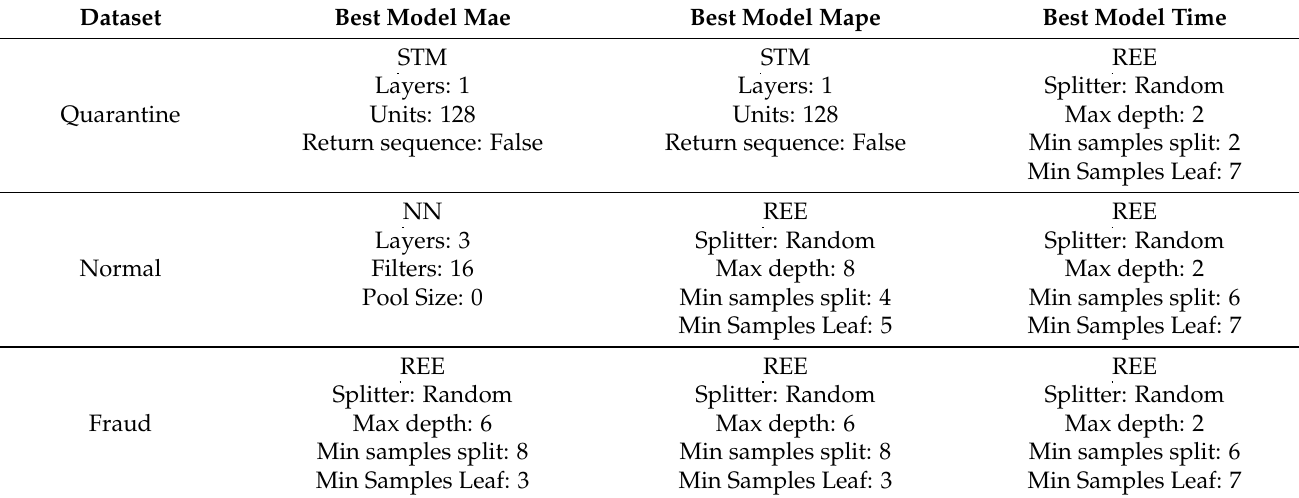
Table 8. Best parameter settings obtained for each dataset and each metric. For each of the possible scenarios, there is a description of which specific algorithm has obtained the best results as well as the best